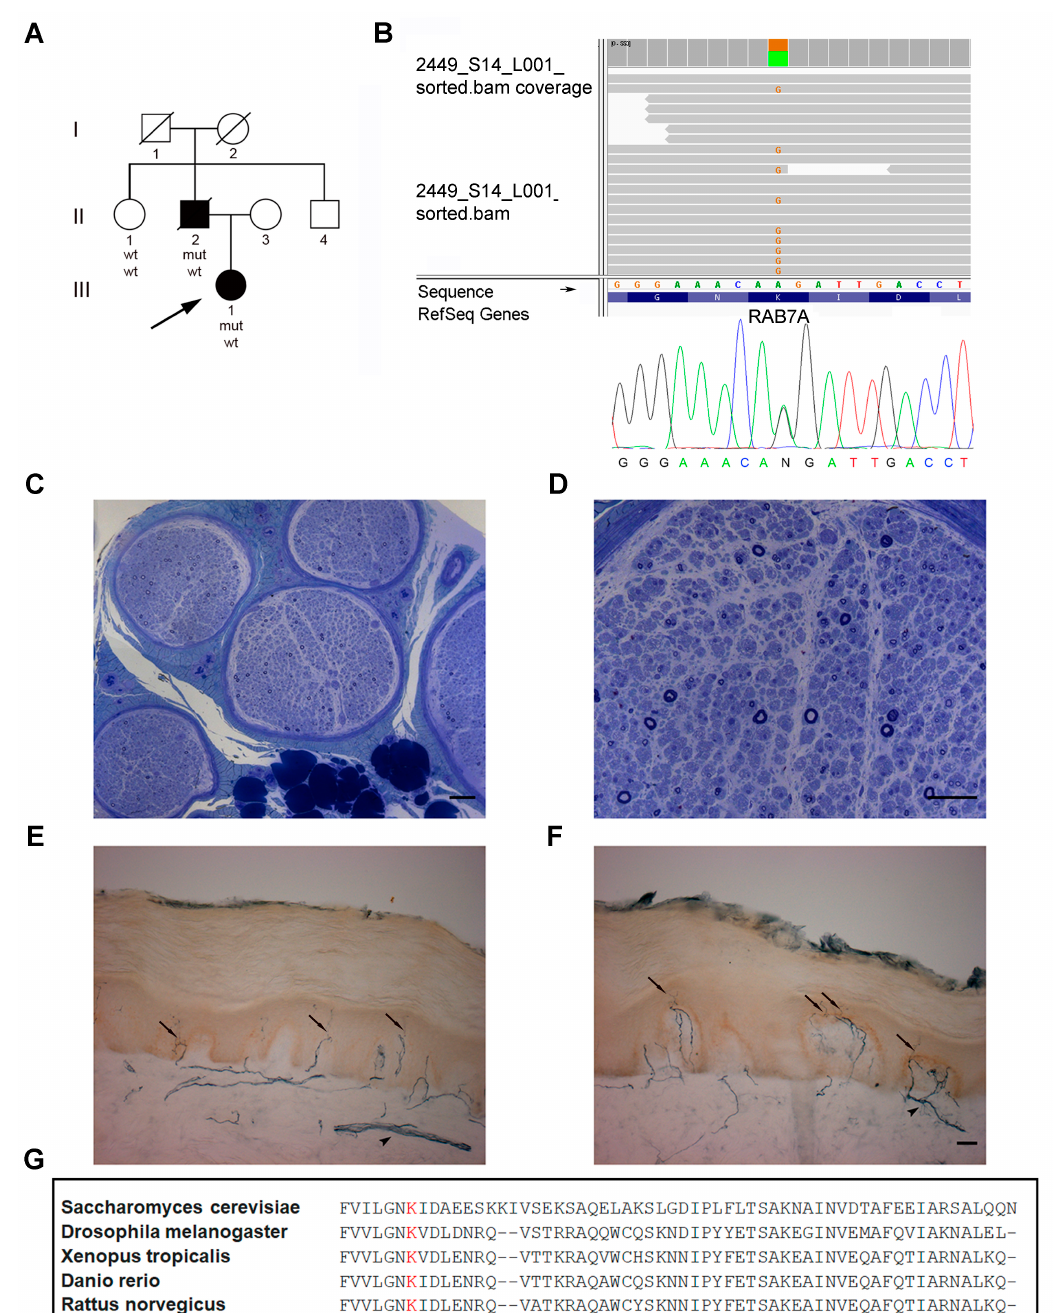
Figure 1. Pedigree, DNA sequencing, nerve, and skin biopsy of the proband. ( A ) Family pedigree. ( B ) Next-Generation Sequencing and Sanger chromatogram of the proband with the heterozygous